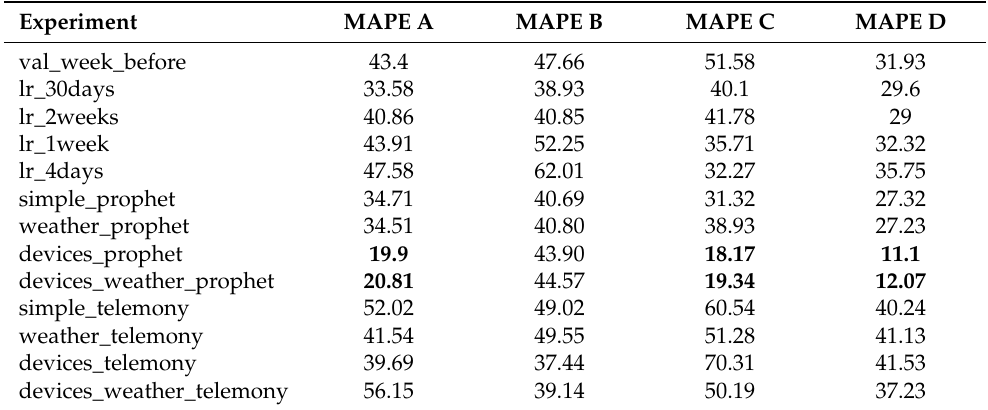
Table 2. The MAPE (mean absolute percentage error) of different model predictions made for 4 locations: A, B, C and D. Results that achieve the MAPE < 25% assumption are marked in bold.